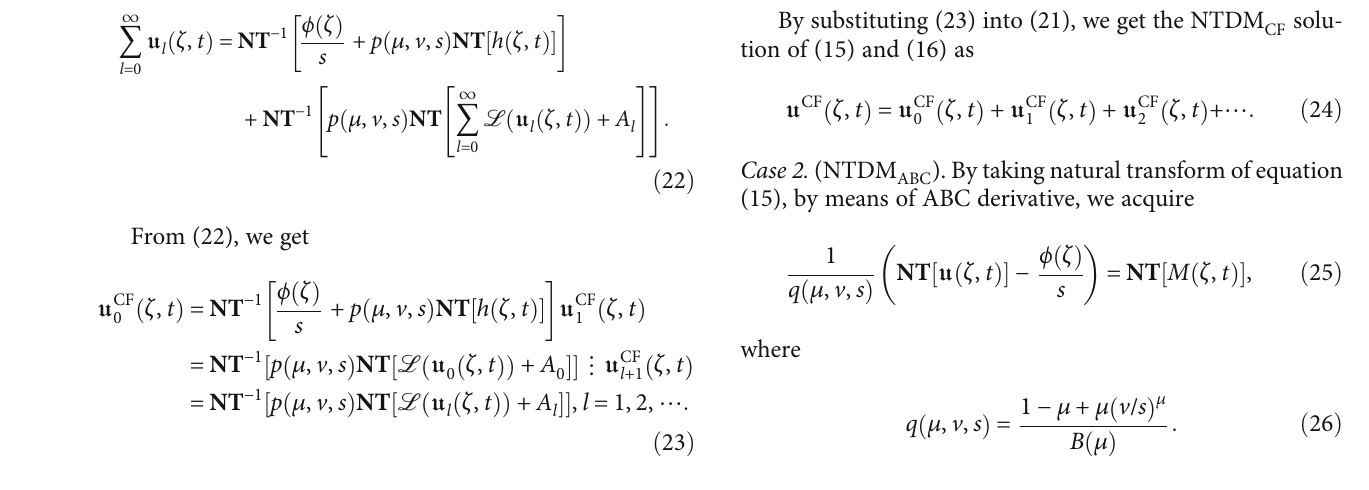
Figure 2: (a) NTDM λ = 0 : 001 of Example